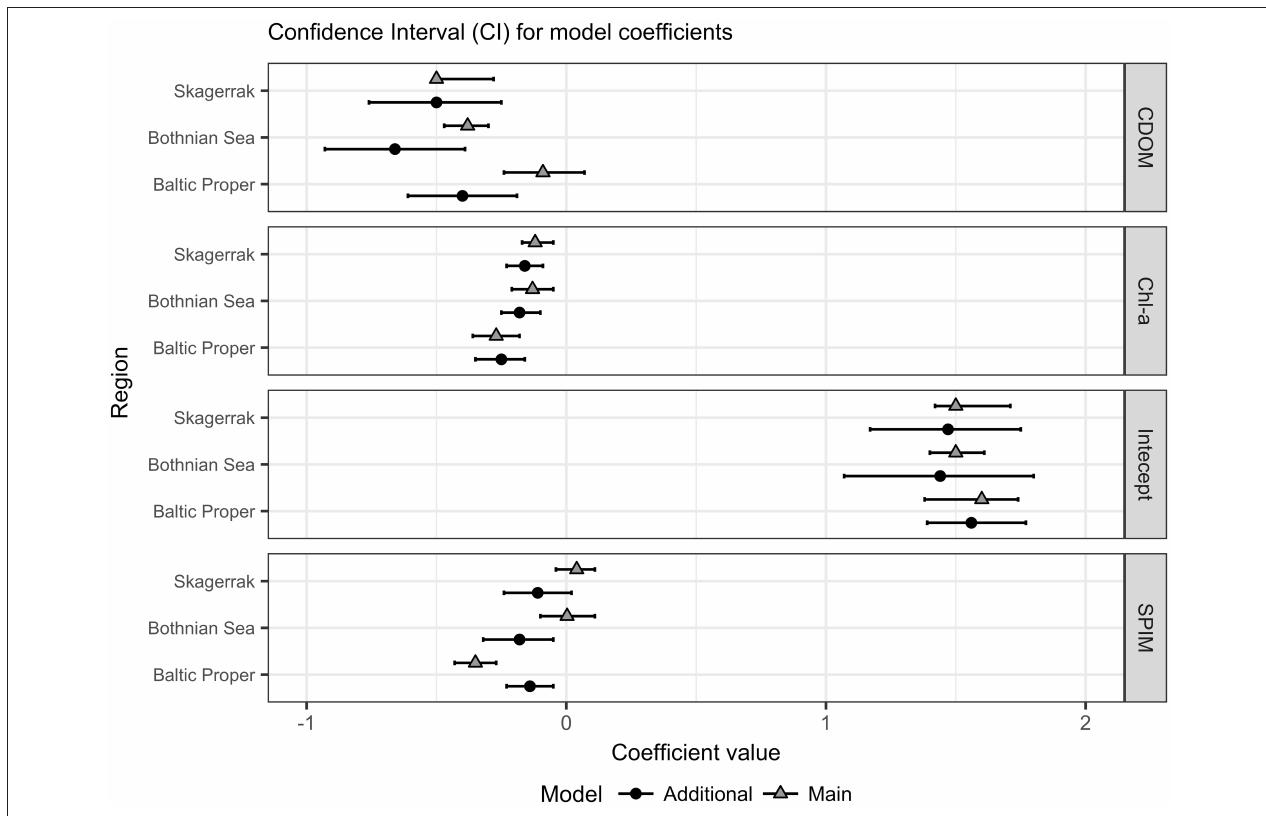
FIGURE 6 | Confidence Interval (CI) for the model coefficients in natural log scale (see Table 3 for model presentations); CDOM slopes, SPIM slopes, Chl-a slopes and Intercepts for each region (BS; BP and SK). Triangles indicate the main models and filled circles the additional. The bar lines show the 95% CI of each estimated coefficient.